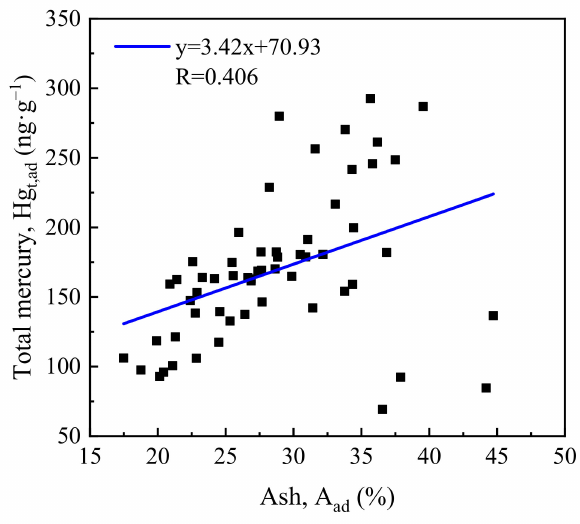
Figure 8. Correlation between Hg and ash in 59 coal samples.